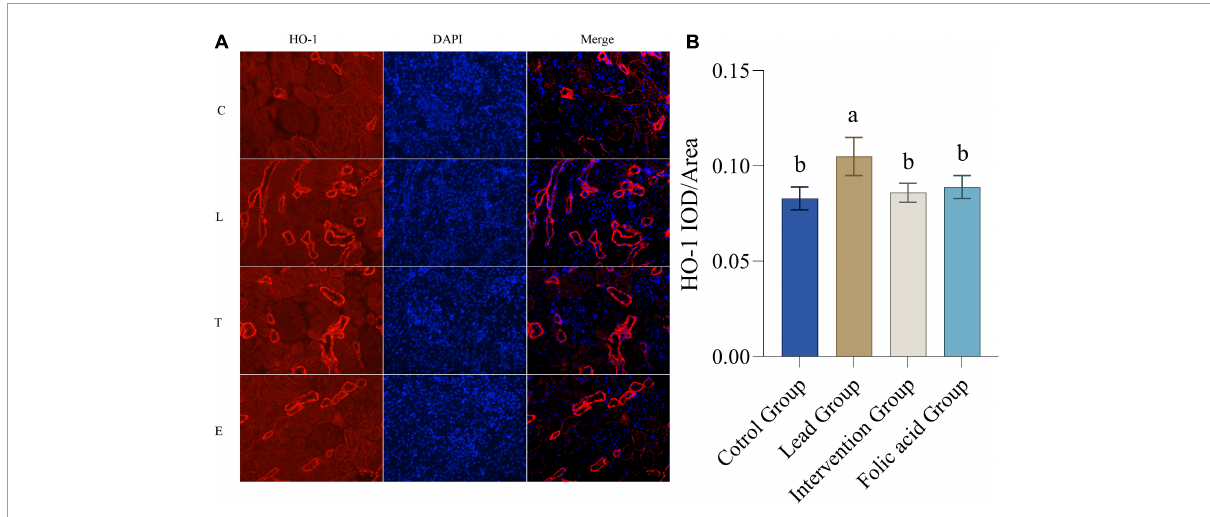
FIGURE4 Effect of folic acid on the expression of heme oxygenase 1 (HO-1) protein in the kidney of lead exposed rats. (A) Immunofluorescence results of HO-1 protein expression (200 × ). (B) The expression level of HO-1 protein is represented by the average integrated optical density value ( n = 6). C: control group; L: lead-exposed group; T: intervention group; E: folic acid group. Data were presented as mean ± SD. Different superscript letters indicate differences ( P < 0.05).